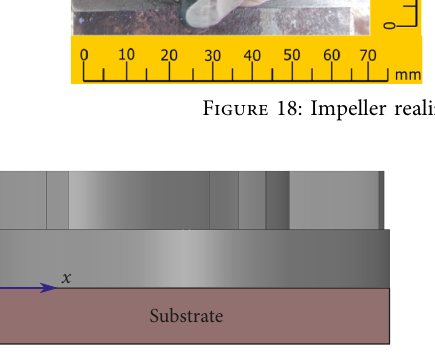
Figure 19: Position of substrate for orientation O (0, 0, 0, 0 ° , 0 ° , 0 ° ).